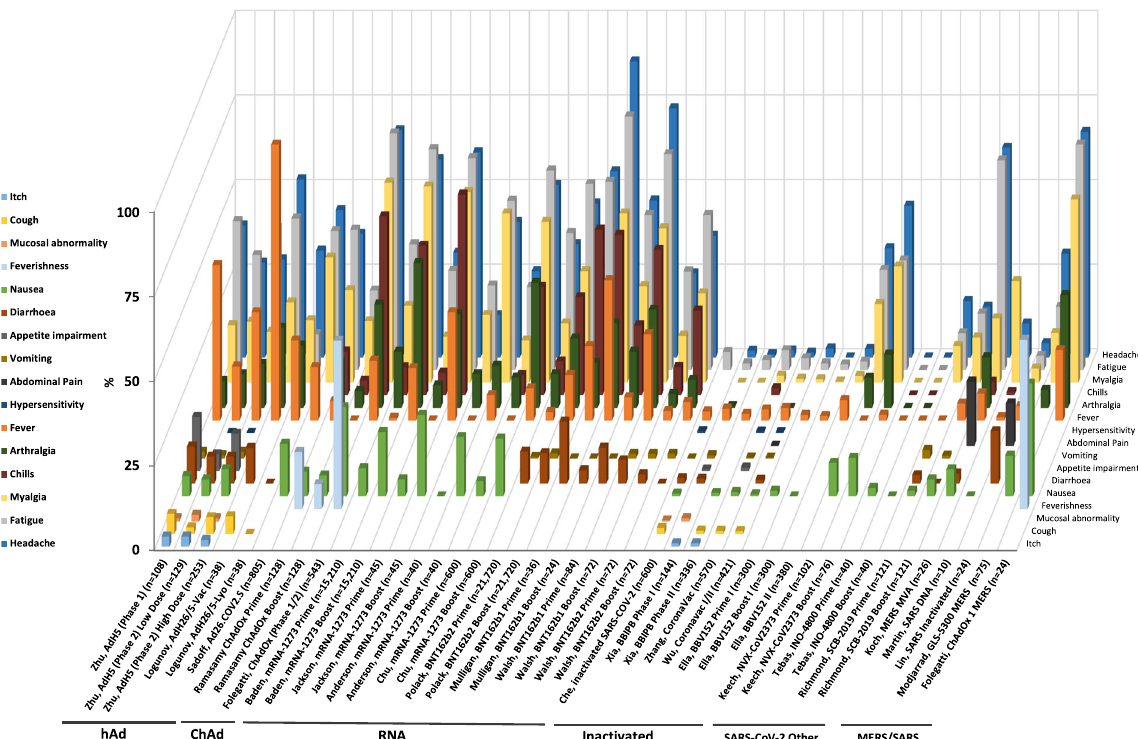
Fig. 4 Interstudy analysis of systematic adverse events reported in vaccine group (excluding control group) of coronavirus vaccine studies. Symptoms are represented by different colors. The percent (%) of vaccines reporting any grade of symptomatic AE is shown. First author and vaccine platform are recorded on the X axis. hAd human adenoviral, ChAd chimpanzee